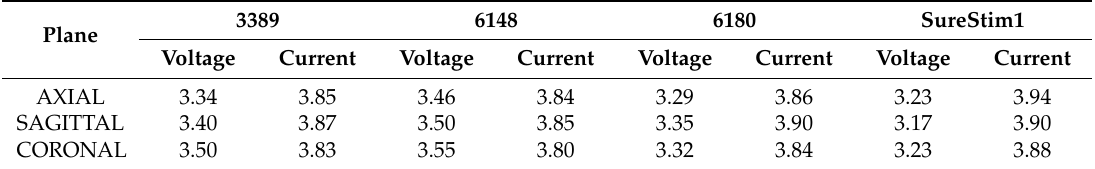
achieved the most similar EF extension (~2.5 mm) and volume (46 mm 3 ) (Figure 10).